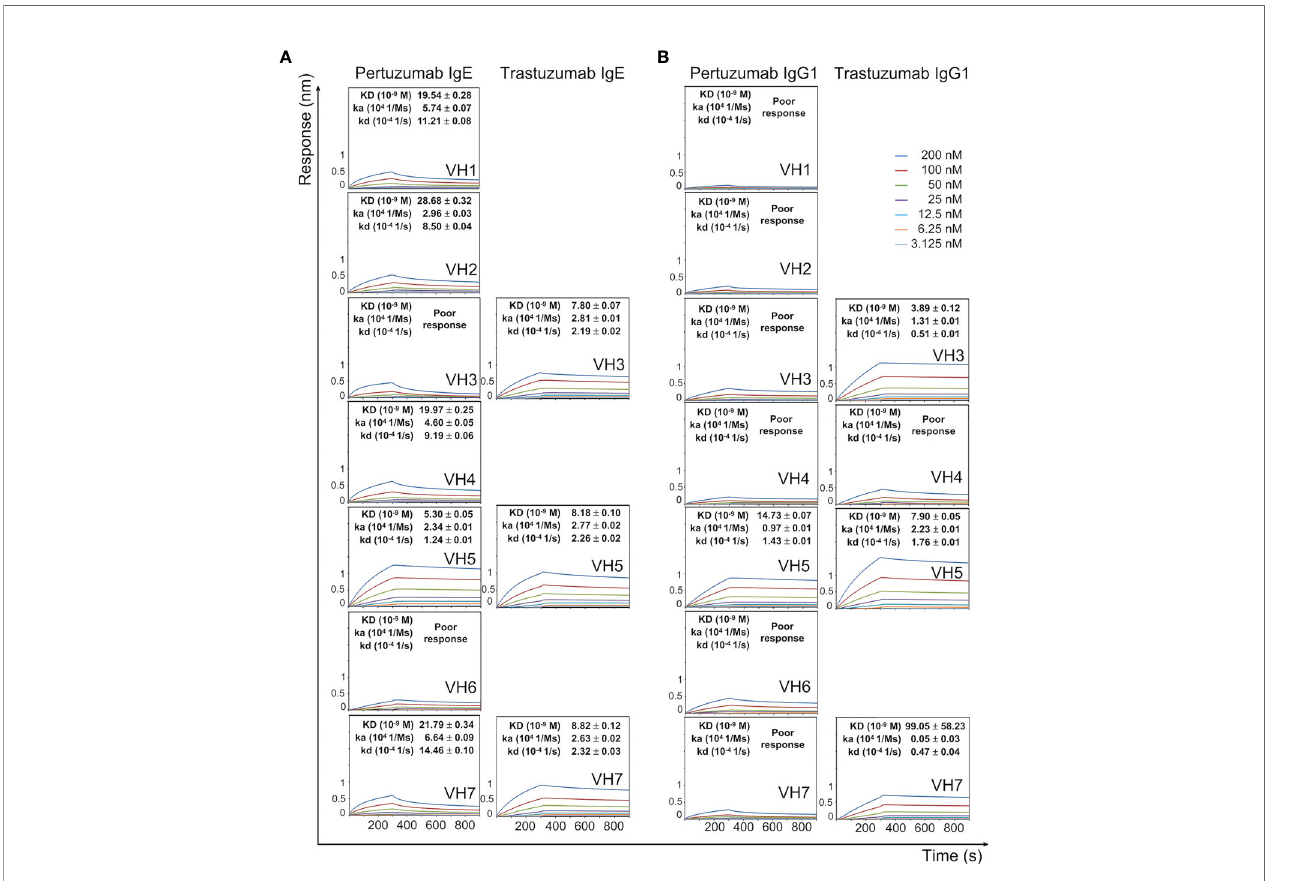
FIGURE 1 | Dissociation equilibrium constants (KD) of Pertuzumab and Trastuzumab IgE (A) and IgG1 (B) of different VH families with the Ni-NTA biosensor. The measurements were performed at concentrations from 200 nM to 3.125 nM of the antibodies. Values of KD (M), ka (1/Ms), and kd (1/s) were determined using the Octet RED96 system. The X-axis depicts the time (in seconds) while the Y-axis depicts the binding responses (nm). All the experiments were conducted in at least duplicates. “ Poor response ” re fl ects measurement responses that are less than 0.1 nm for at least three concentrations. Variants that could not be produced are left